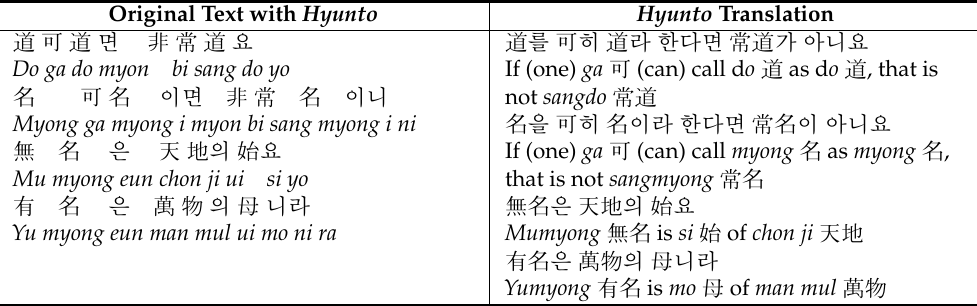
Table 1. Tanheo’s translation of the beginning of the first chapter of DDJ. Original Text with